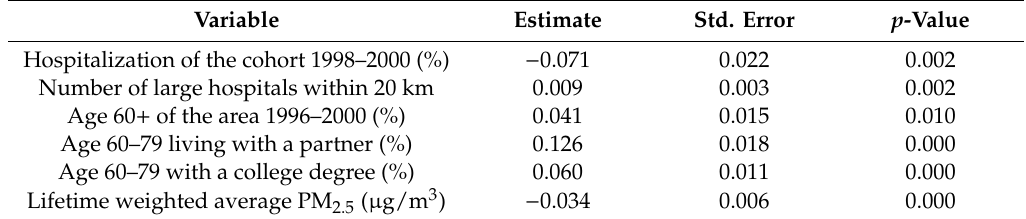
Table 2. Effect estimates of influential variables associated with standardized life expectancy deviation (years) from the weighted regression model with spatially correlated error terms.